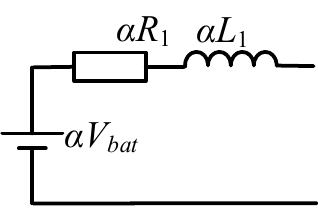
Figure 5. Equivalent model of battery and bidirectional DC/DC converter. The bidirectional DC/DC converter of a SC utilizes a power outer loop and a current inner loop; consequently, the SC and the DC/DC converter are equivalent to a controlled power source whose power is P sc , as shown in Figure